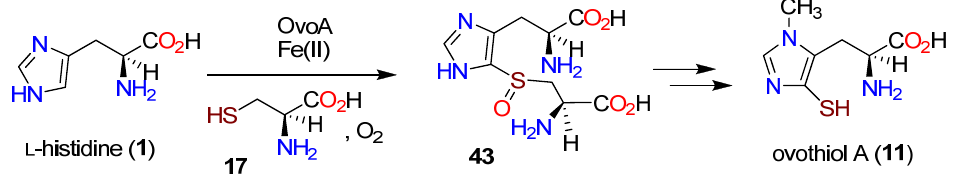
Figure 10. Formation of the sulfoxide intermediate 43 from L -histidine ( 1 ) and L -cysteine ( 17 ) by OvoA (adapted from ref. [101]).